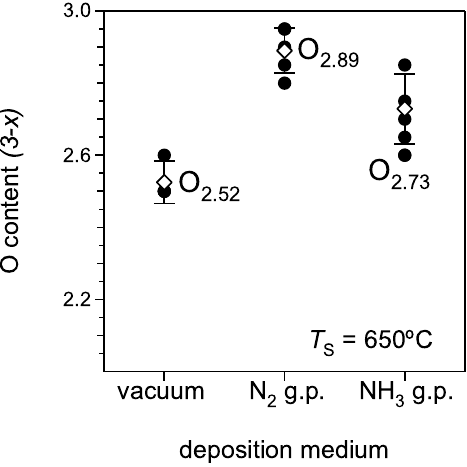
Figure 3. Average oxygen stoichiometry factors of films prepared in vacuum, with the ammonia and the nitrogen gas pulse. The open symbols are the calculated mean values and the error bars show the respective confidence intervals for the different deposition